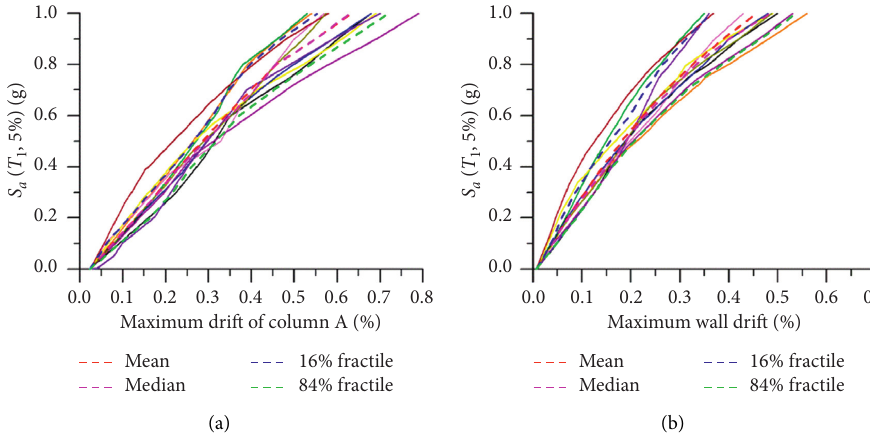
Figure 14: IDA curves of drift ratio. (a) Column A and (b) wall.